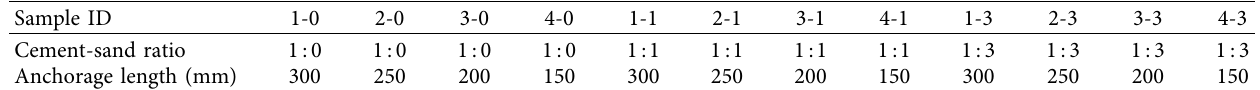
Table 1: Sample ID, cement-sand ratio, and anchorage length.